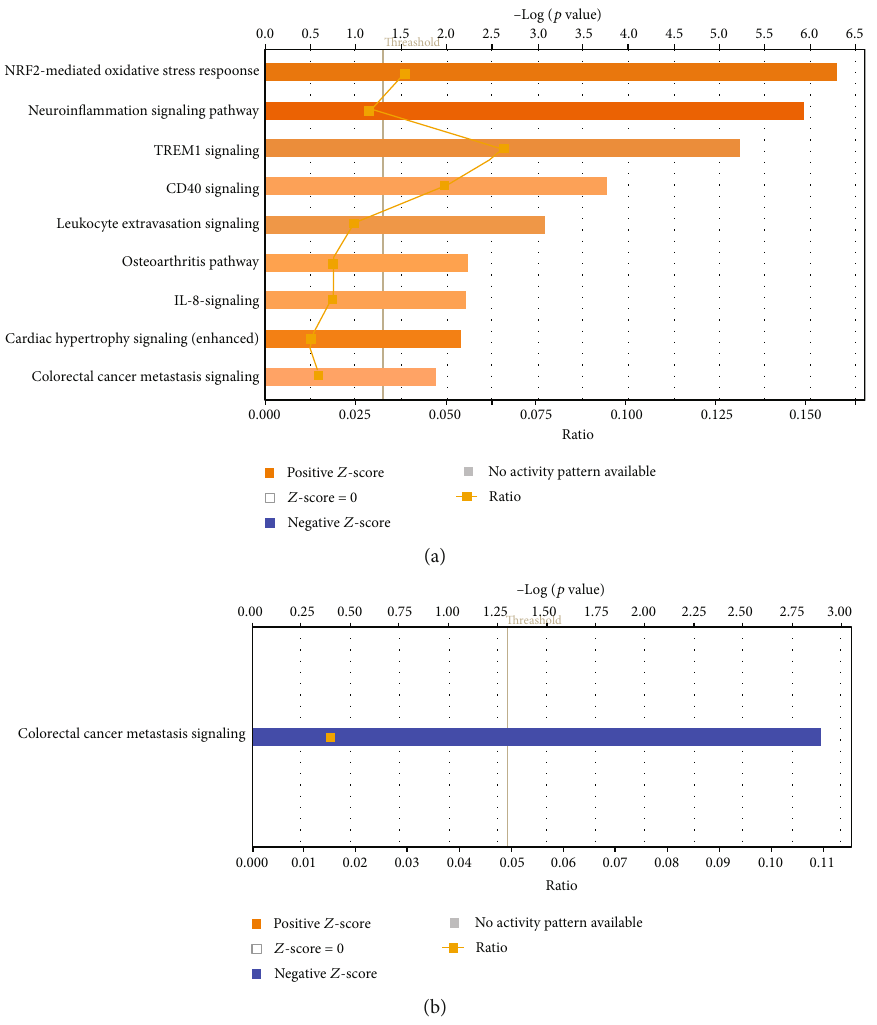
Figure 1: (a) Low-intensity ultrasound (LIUS) upregulated 77 out of 1376 (5.6%) innatomic genes and downregulated 39 out of 1376 (2.8%) innatomic genes (IIGs) in human lymphoma U937 cells (GSE10212), suggesting that (1) LIUS increases innatomic gene expressions more than it decreases them in cancer cells in human lymphoma cells, and (2) upregulation of innatomic genes in lymphoma cells serves as